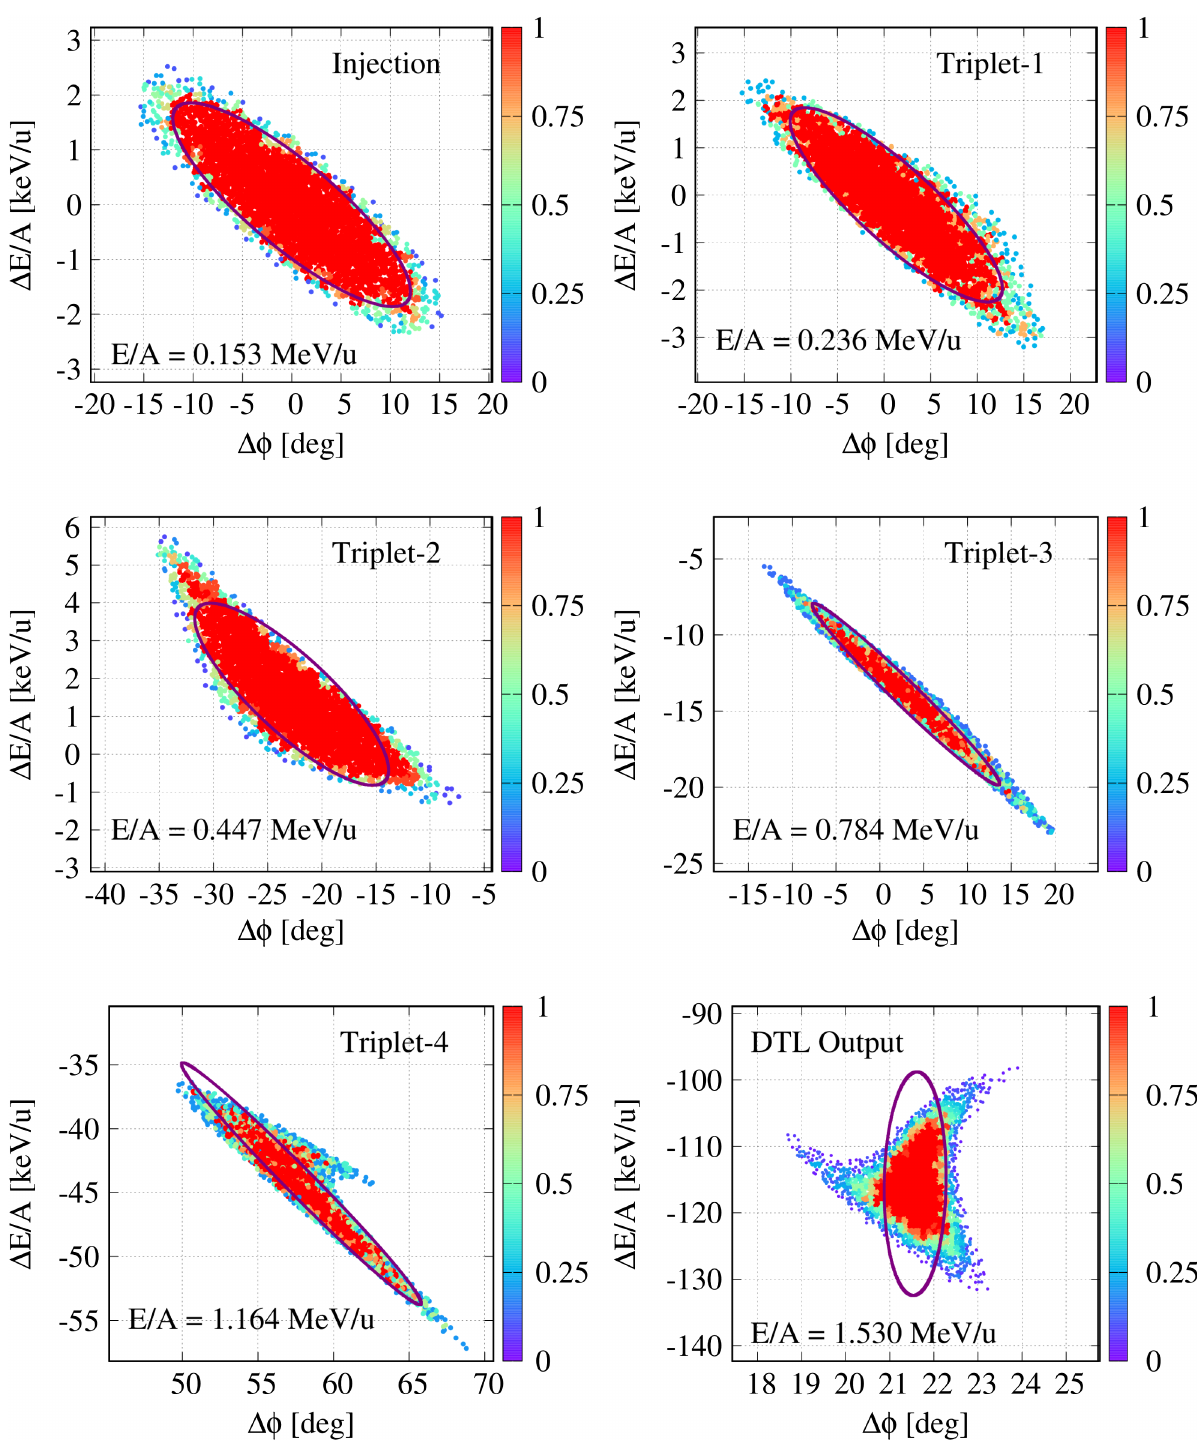
FIG. 6. Coordinate 5, 6 phase space distributions: LORASR normalized density for 5000 particles (points) and TRANSOPTR 4 rms containment ellipses (purple) at injection and through the ISAC-DTL, for the envelopes shown in Fig. 5, with input beam parameters shown in Table II. Both graph scales are with respect to the synchronous particle through each cavity, computed in LORASR . Normalized color density scale shown on the right of each plot. The intermediate distributions are shown at the exit of each triplet, with the energy per nucleon shown in each graph. As the bunch progresses through the linac, second-order components of the accelerating fields cause rf filamentation, which is represented in the multiparticle code. On the other hand, TRANSOPTR ’ s ellipse arises only from the linear component of the forces, which nevertheless agrees with the core of the multiparticle beam simulation. The DTL output distribution consists of 10 000 particles, highlighting the core of the distribution, where higher order effects are